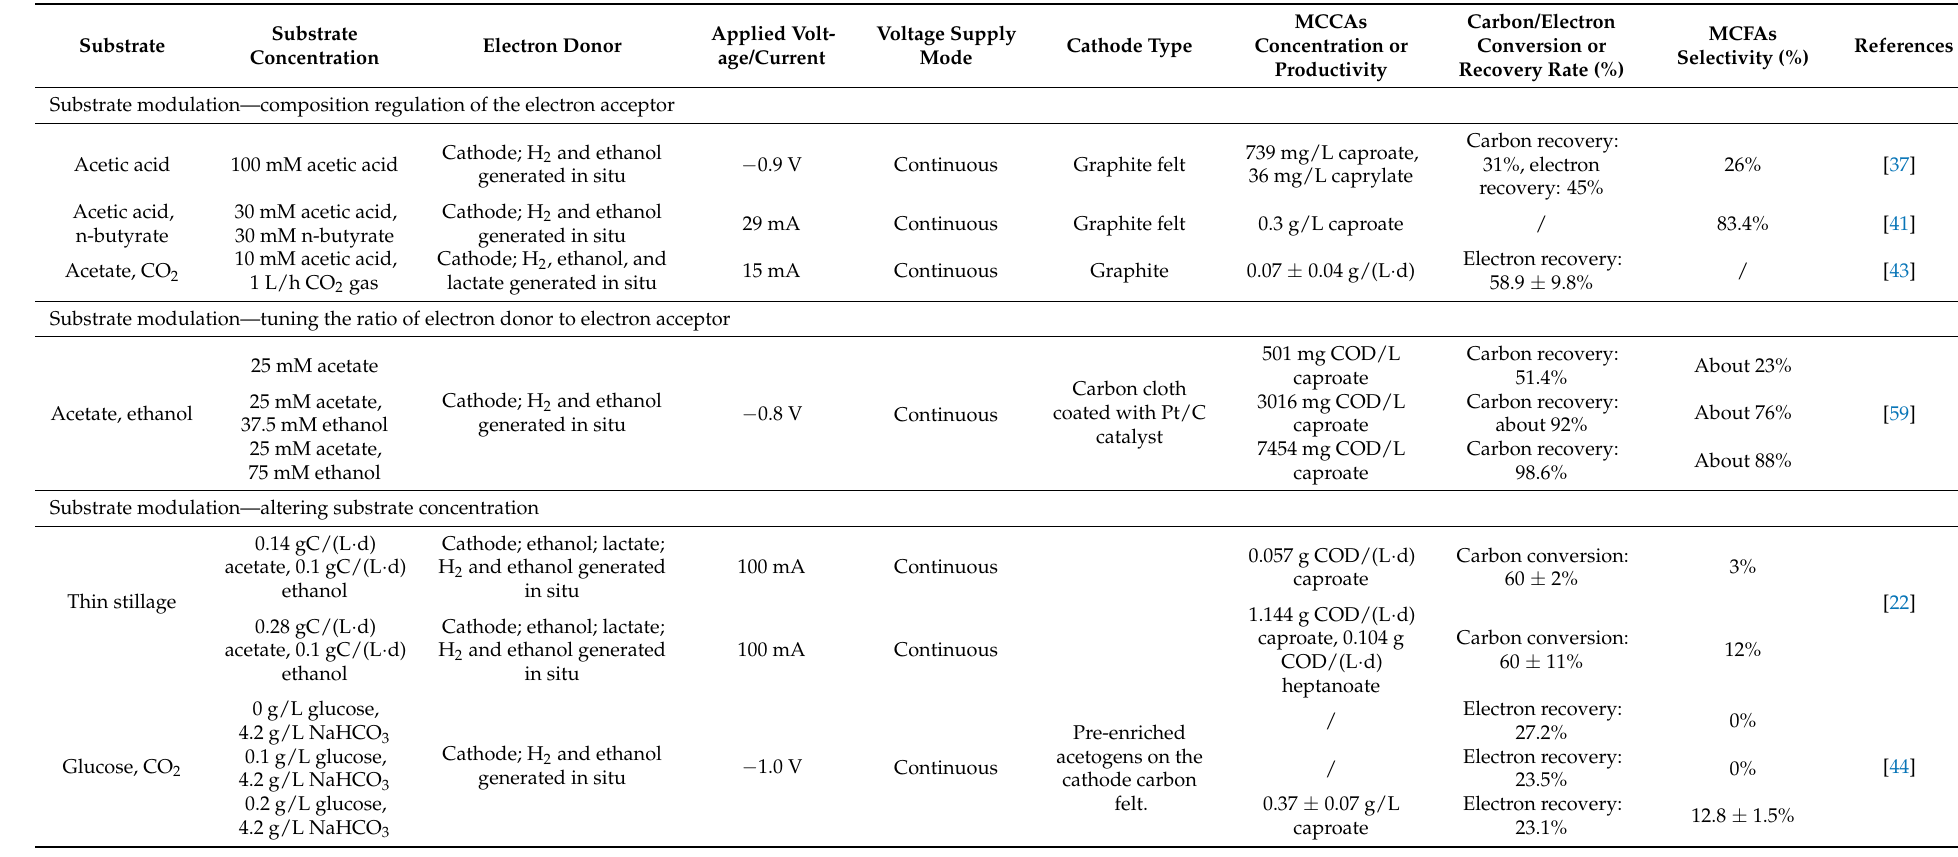
Table 2. Dominant microbes in MCCAs electrofermentation mixed microbial culture